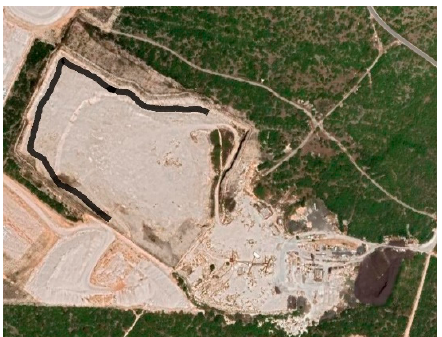
Figure 1. Test site with the marked location of the test blasts area. The large number of measurement instruments were positioned in a single line at a predefined distance from the blast (up to 8 instruments). A larger number of instruments was required due to the impossibility of the Instantel software “Blastware” to calculate the regression line with a 95%-line equation with less than 4 measurement points. The measurement data of seismic effects for all 17 boreholes include the distance of the measurement instruments from blasting zone, the PPV for each spatial component (longitudinal, transversal, and vertical), and peak vector sum (PVS) (Table 1). Table 1. The measurement data of the blast-induced seismic effects for all 17